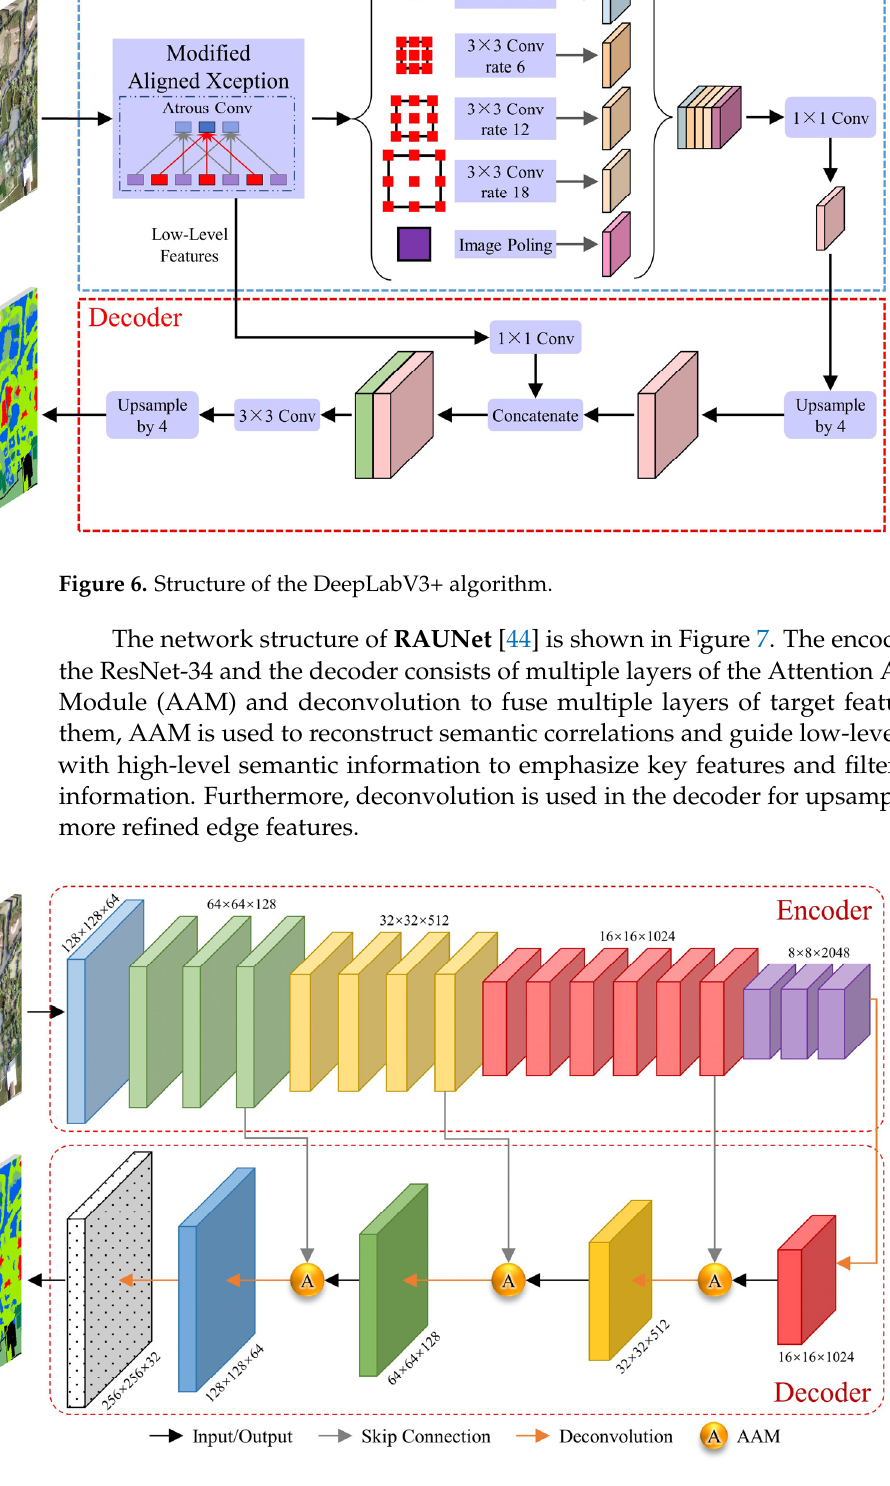
Figure 7. Structure of the RAUNet algorithm.